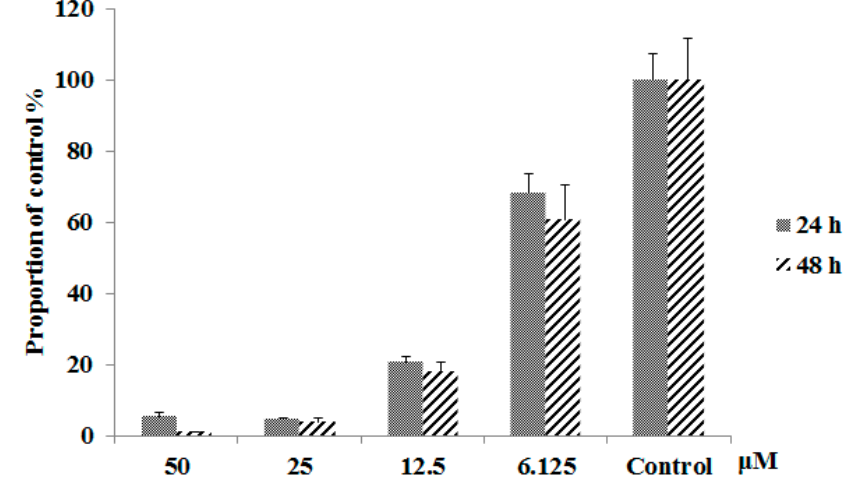
Figure 7. The changes of mitochondrial membrane potential (MMP) in L02 cells after treatment with emodin for 24 h and 48 h under different concentrations, (means ± SD, n = 3).